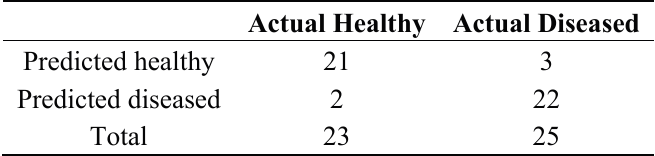
Figure 15. The smellprint ( a ) and PCA score plot ( b ) of healthy and sour skin infected onions. The correct classification rate was 89.6% with two healthy samples misclassified as diseased (4.1% false positive) and three diseased misclassified as healthy (6.3% false negative) (Table 4). The tests proved the efficacy of the customized gas sensor array for diseased onion detection. Table 4. Classification confusion table of healthy and sour skin infected